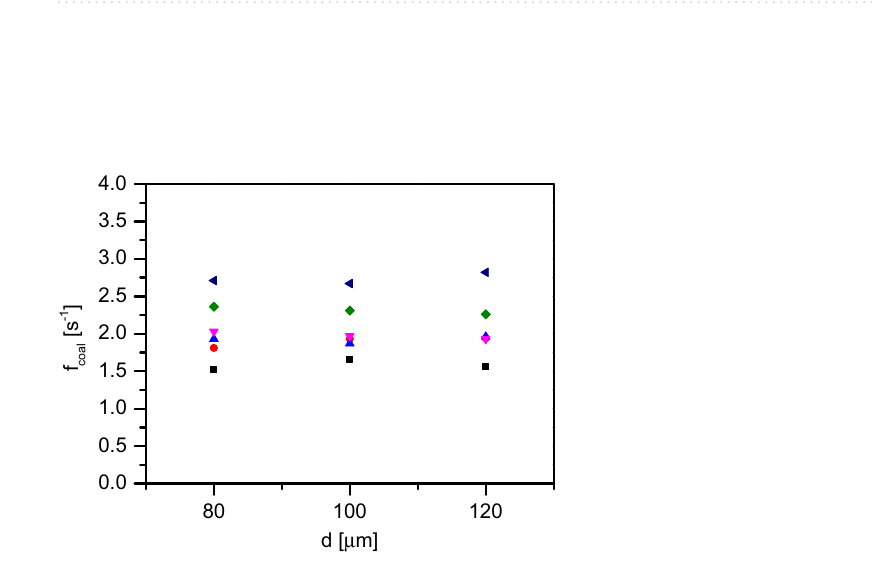
◦ C (black ◦ C (green